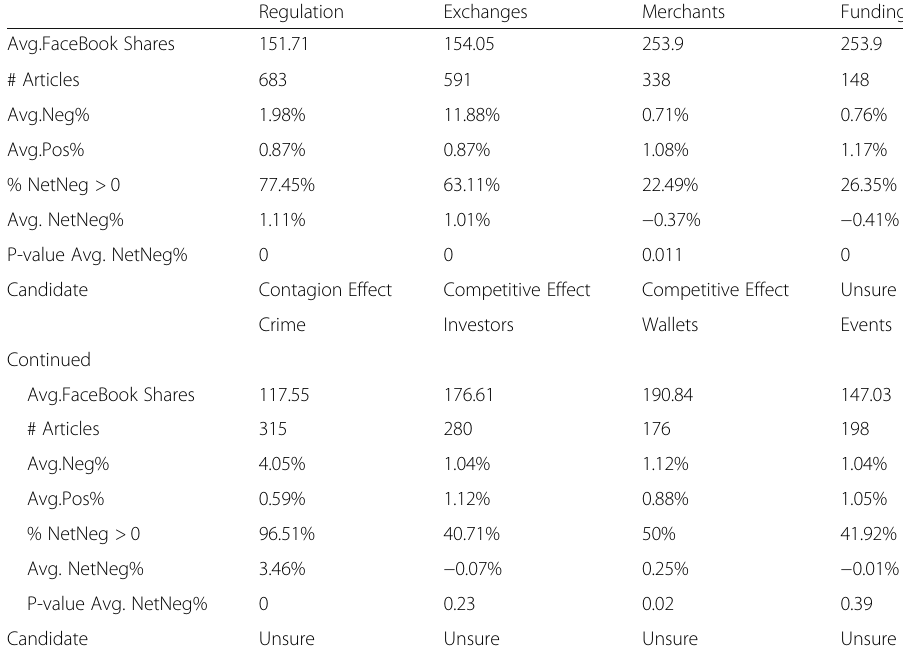
Table 3 Descriptive Statistics: Information